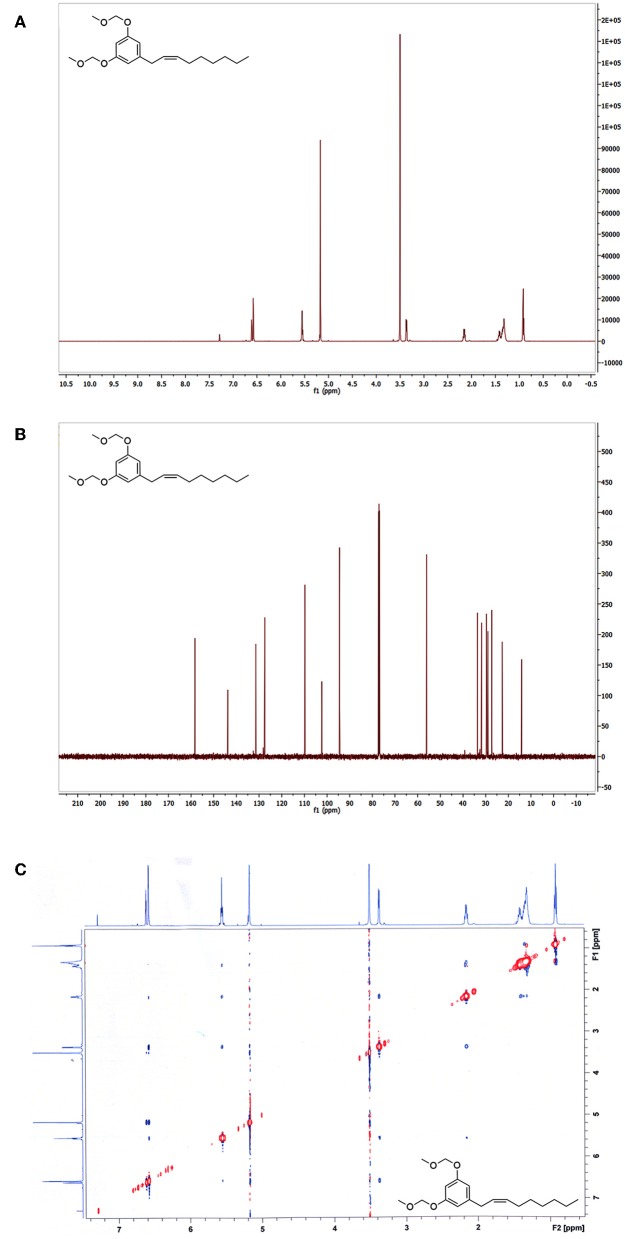
(A)
1H-NMR, (B)
13C-NMR, and (C)
1H-1H ROESY spectra of MOMO.